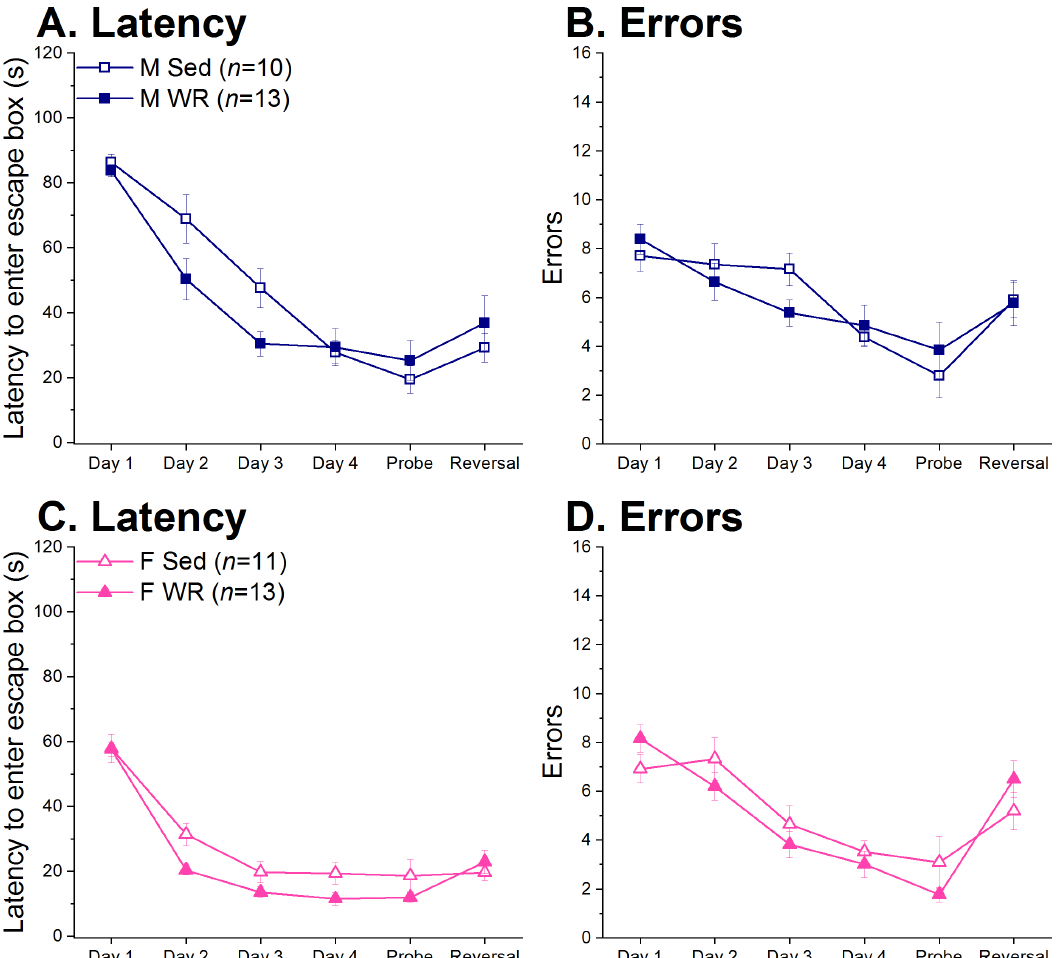
Figure 8. Barnes maze results for males (M, top) and females (F, bottom). ( A , C ) Both male and female rats decreased latency to locate the escape box during training. On average, females had shorter latencies to find the escape box than males across training days. ( B , D ) All groups committed fewer errors when searching for the escape box across training days.